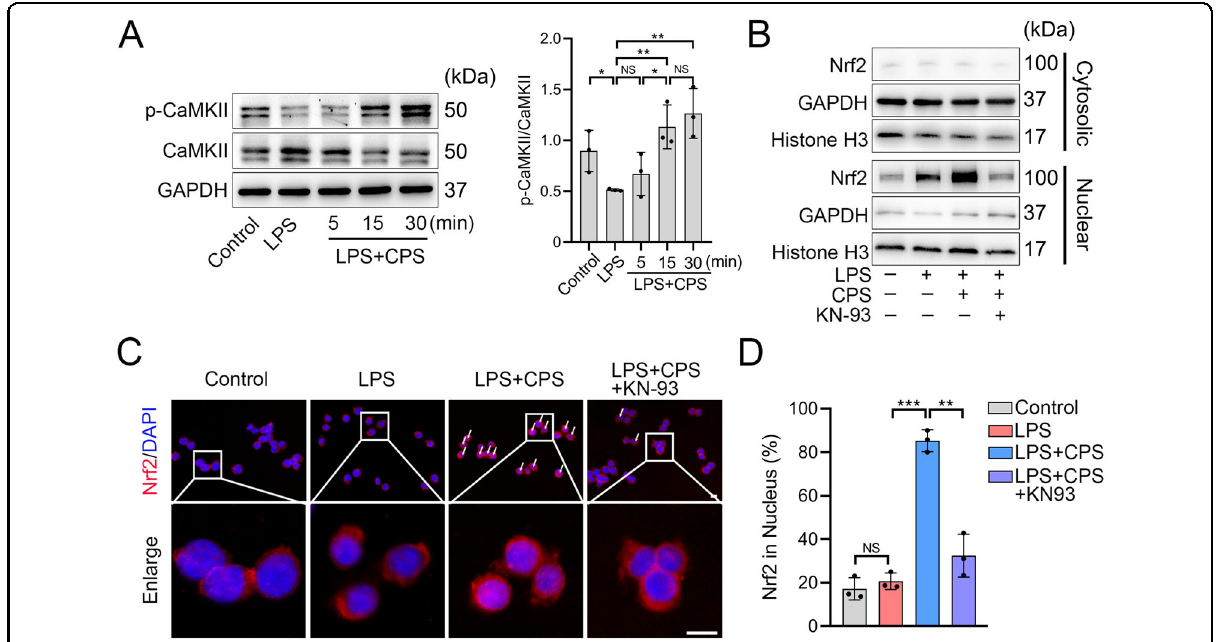
Fig. 6 CaMKII mediates the TRPV1-promoted Nrf2 nuclear translocation in RAW264.7 cells. A Western blot and quantitative analyses of CaMKII and p-CaMKII protein levels in the cells treated with LPS with or without CPS for 5, 15, and 30 min. B Western blot analysis of cytosolic and nuclear Nrf2 protein levels in the cells treated with LPS and LPS + CPS with or without KN-93 for 3 h. C Immuno fl uorescence images and D quantitative analysis of Nrf2 in the cells treated with LPS and LPS + CPS with or without KN-93 for 3 h. Scale bars: 10 μ m. Data ( n = 3) are shown as mean ± SD. * P < 0.05; ** P < 0.01; *** P < 0.001; NS nonsigni fi